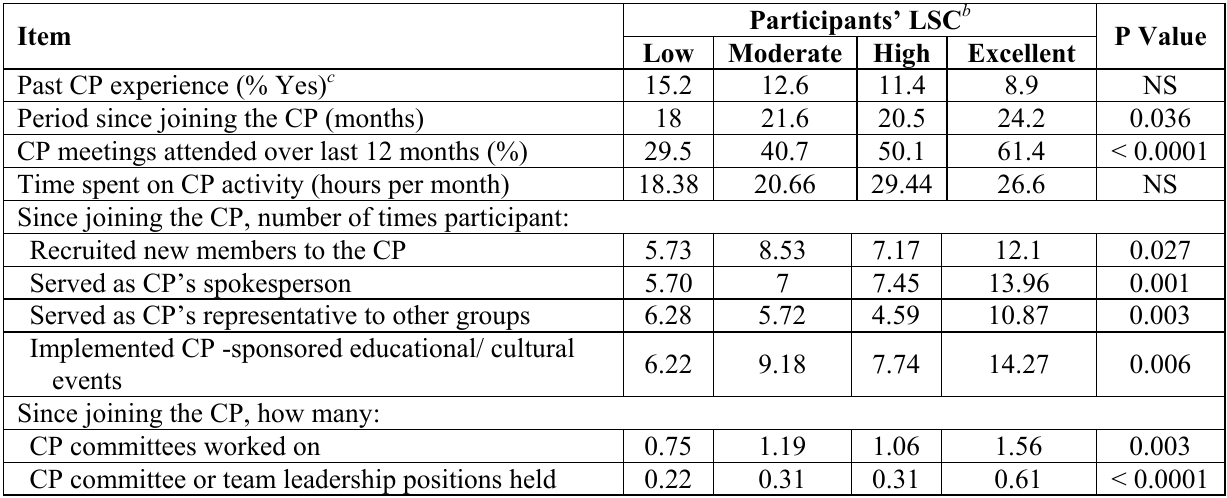
Table 2. Confirmatory items: 10 aspects of participants’ engagement and involvement a